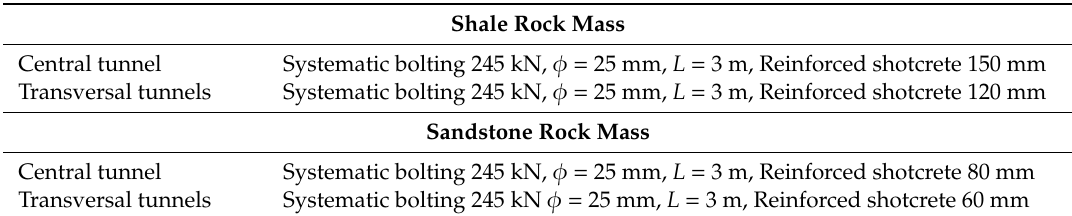
Table 3. Support system design.